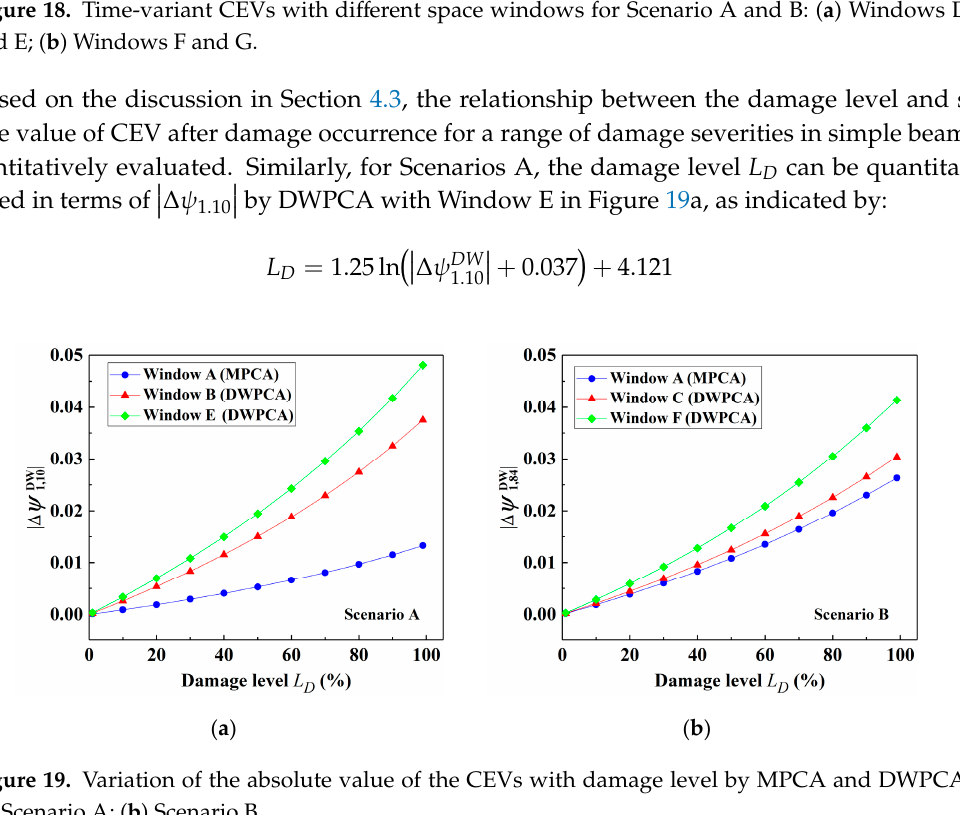
Figure 18. Time-variant CEVs with different space windows for Scenario A and B: ( a ) Windows D and E; ( b ) Windows F and G.